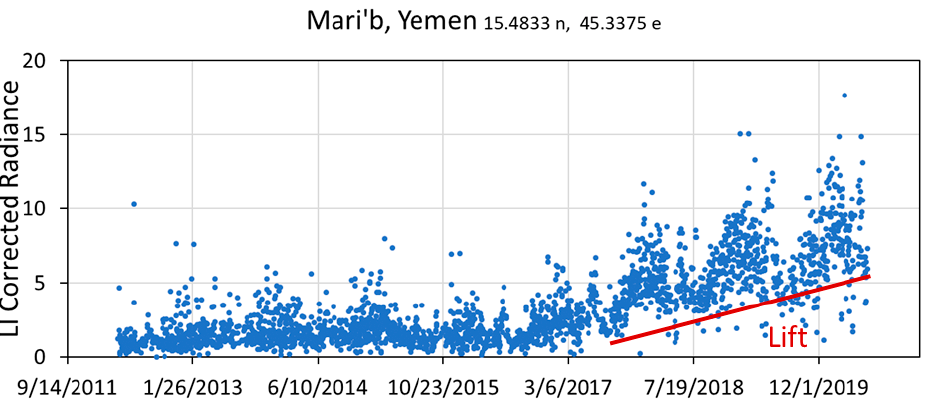
Figure 16. This grid cell started out with nearly zero lift. Lift began to rise midway through 2017.